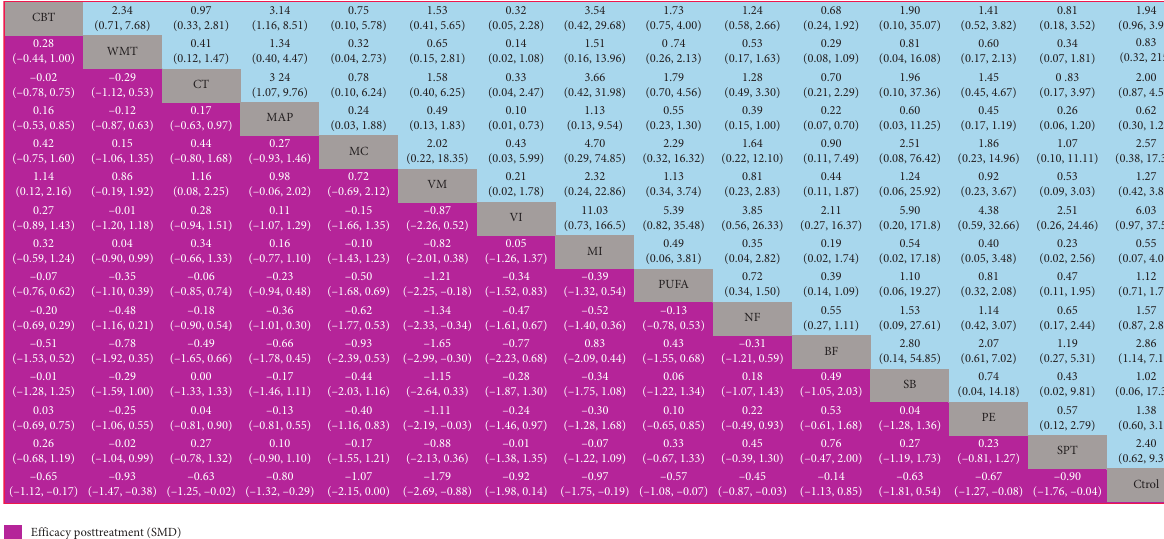
Figure 6: The results of network meta-analysis for efficacy and